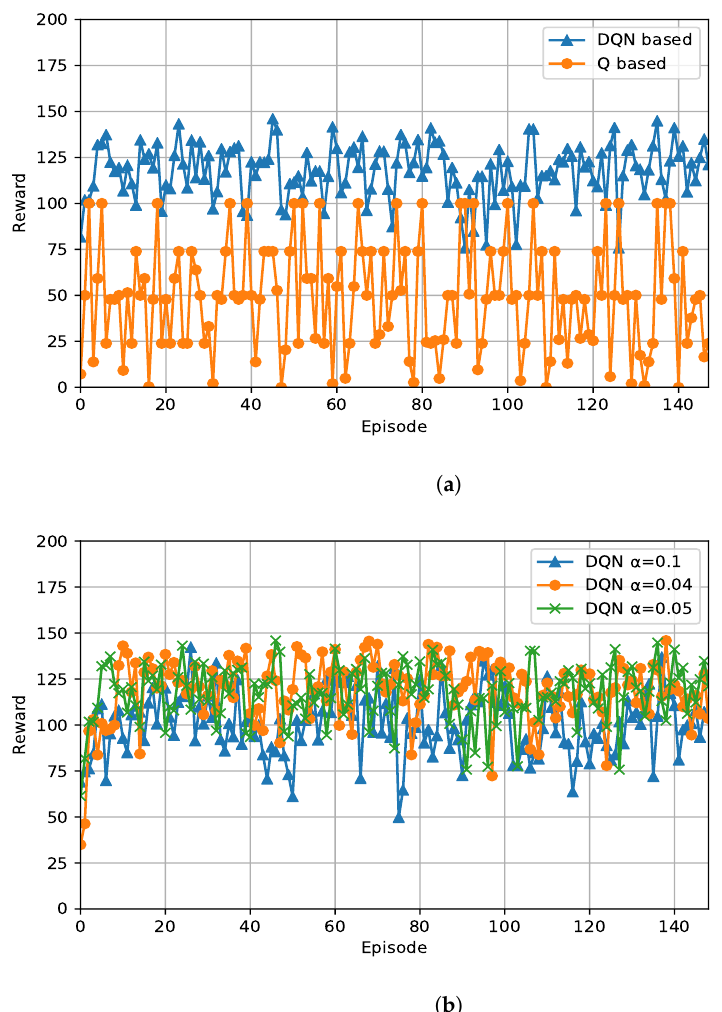
Figure 5. Convergence plot of Q -based and DQN-based algorithms: stability of reward values despite a random access network environment. Reward values are computed for every other episode. ( a ) Comparison between RL approaches for reward values in random access network environment; ( b ) reward values for DQN-based algorithm: different learning